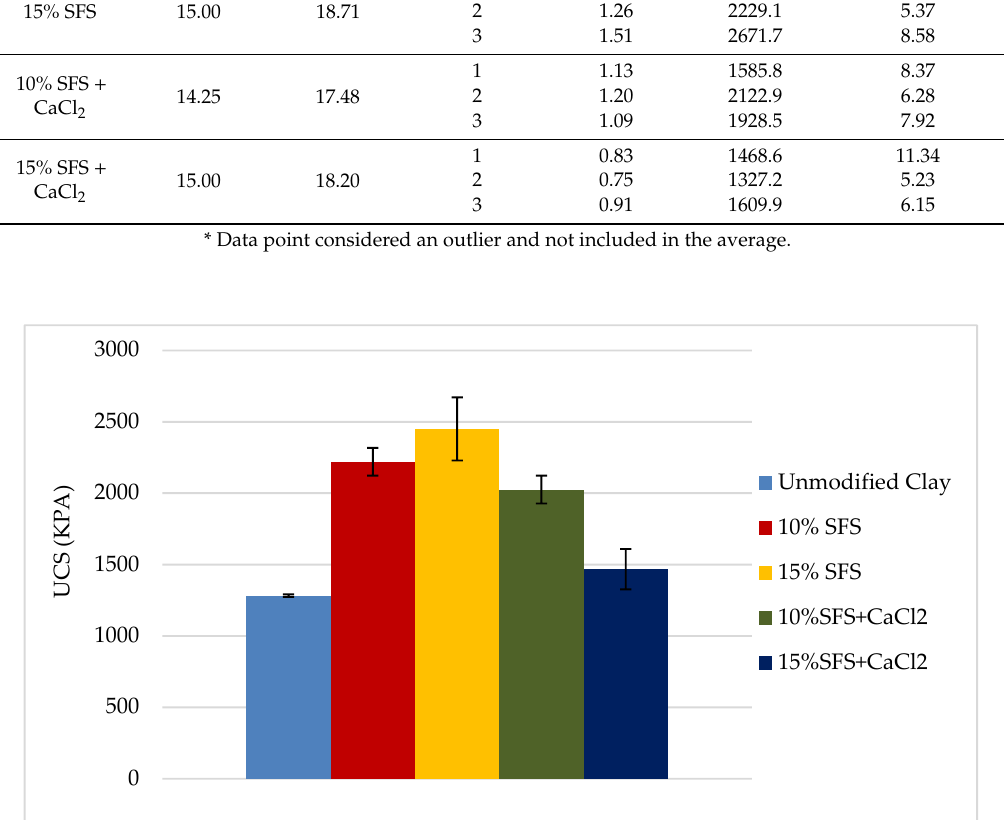
Figure 5. Average UCS for each mixture. Error bars indicate one standard deviation.